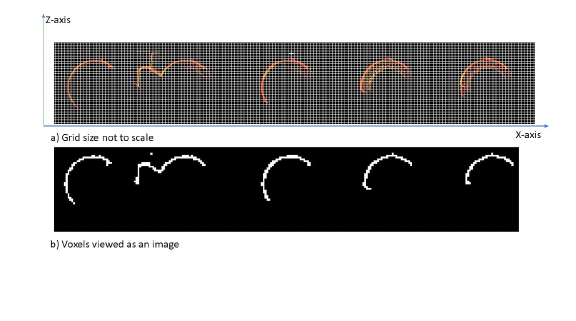
Figure 6. Laser points in the X-Z plane. (a) Voxel overlaid on the point cloud and (b) image created by thresholding the number of laser points within each voxel.